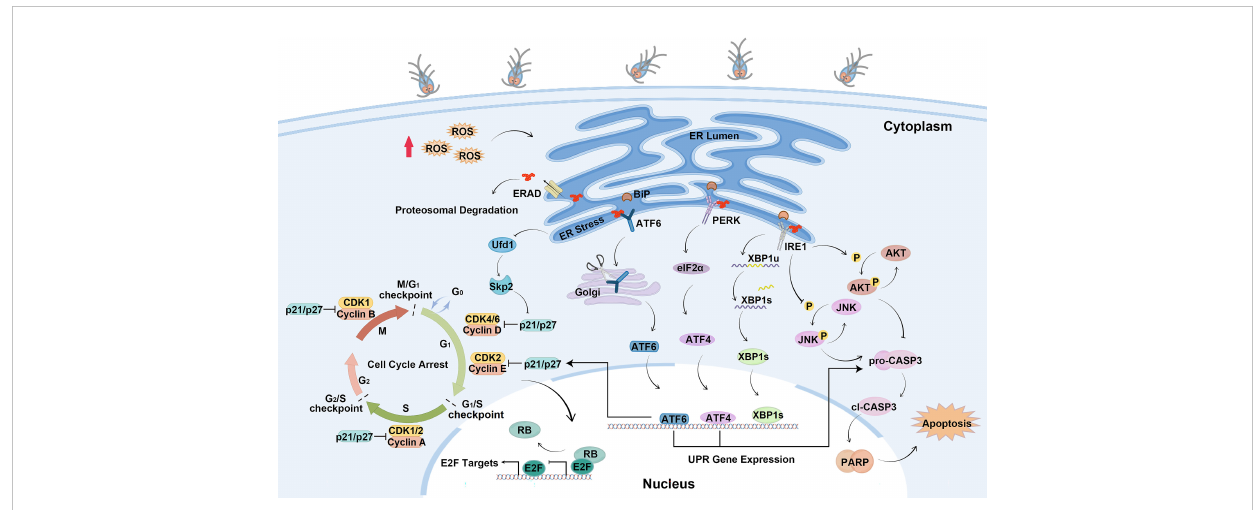
FIGURE 8 Schematic diagram illustrating the molecular mechanism of cell cycle arrest and apoptosis regulated by ER stress during Giardia exposure (by Figdraw, https://www. fi gdraw.com).